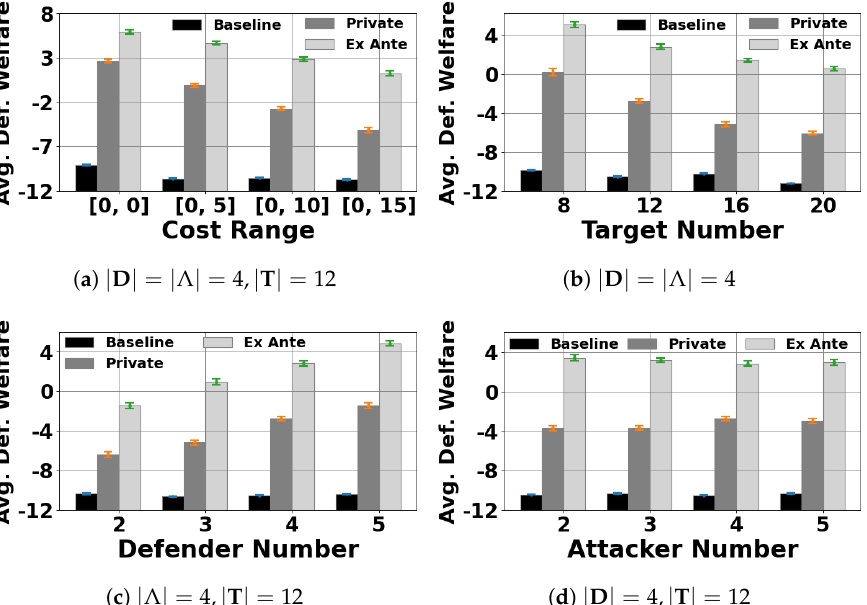
Figure 1. Average defender social welfare: the defenders’ cost range is fixed to [ 0,10 ] in sub-figures ( b – d ).